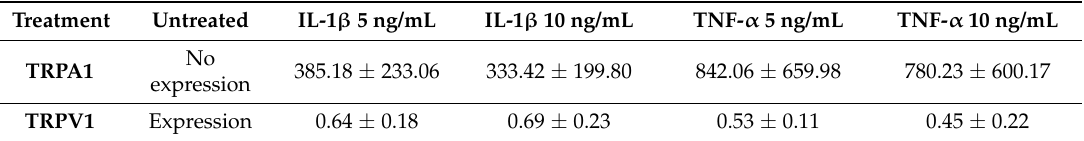
Figure 1. Gene expression of TRPA1 and TRPV1 in IVD cells treated with 5 and 10 ng/mL interleukin-1 beta (IL-1 β ) or tumor necrosis factor alpha (TNF- α ). Gene expression of ( A ) TRPA1 and ( B ) TRPV1 in two-dimensional (2D) culture (Graph shows 2 − dd C t (mean ± SD, n = 5). Gene expression of ( C ) TRPA1 and ( D ) TRPV1 in IVD cells cultured in three-dimensional (3D) alginate beads and treated with IL-1 β for 15 days. Graph shows 2 − dd C t (mean ± SD, n = 4–10). Asterisks indicate statistical significance (* p < 0.05, ** p < 0.01, Kruskal–Wallis test and Dunn’s multiple comparison test). ( E ) Protein expression of TRPA1 in IVD cells treated with IL-1 β and untreated (DAPI = blue, TRPA1 = green). Negative control images show cells without secondary antibody. Scale bar is 50 µm. Table 2. Gene expression of TRPA1 and TRPV1 in untreated and treated human IVD cells (2D). n = 5 donors. Values show fold change relative to the untreated cells. In case of expression under the detection limit, d C t was set at 40 cycles.